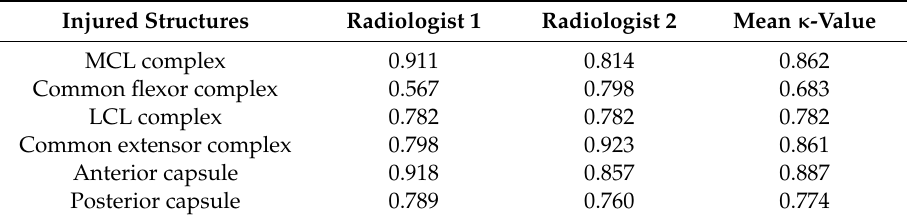
Table 3. Intraobserver agreement between radiologist 1 and 2 per injured